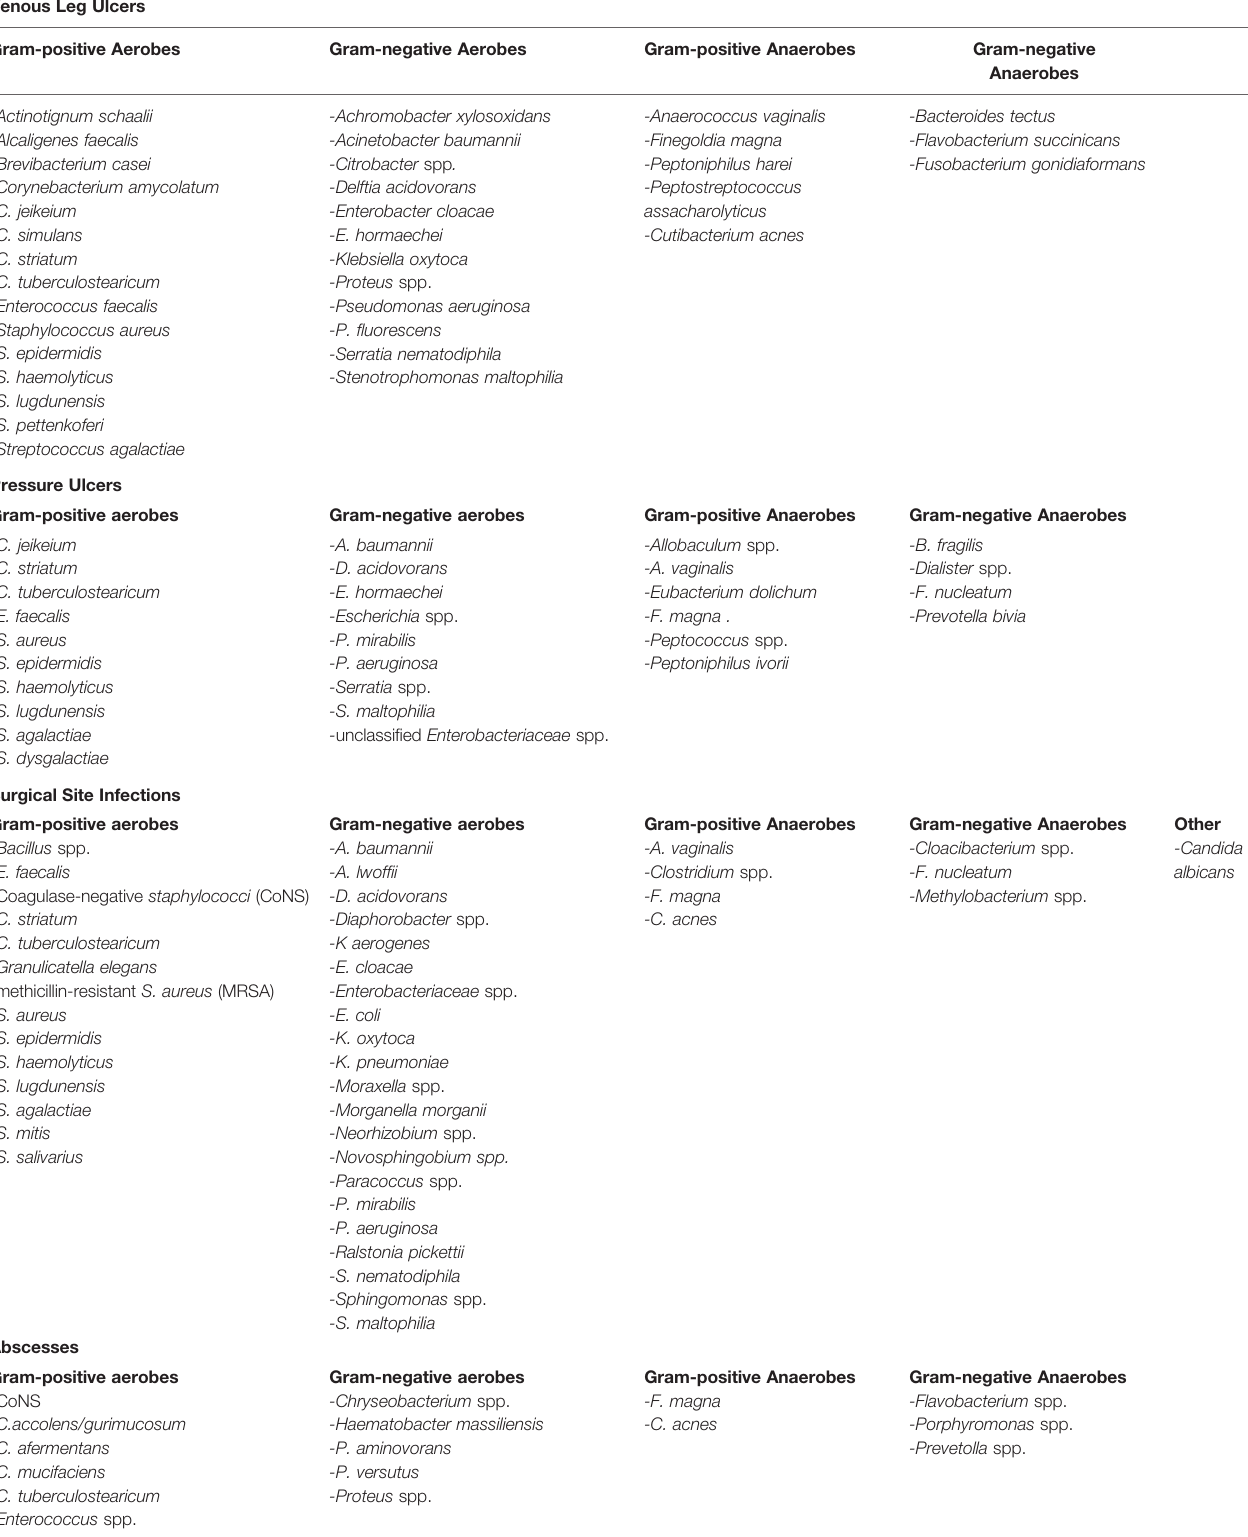
TABLE 1 | Summary of most common bacterial species found in chronic wounds (excluding